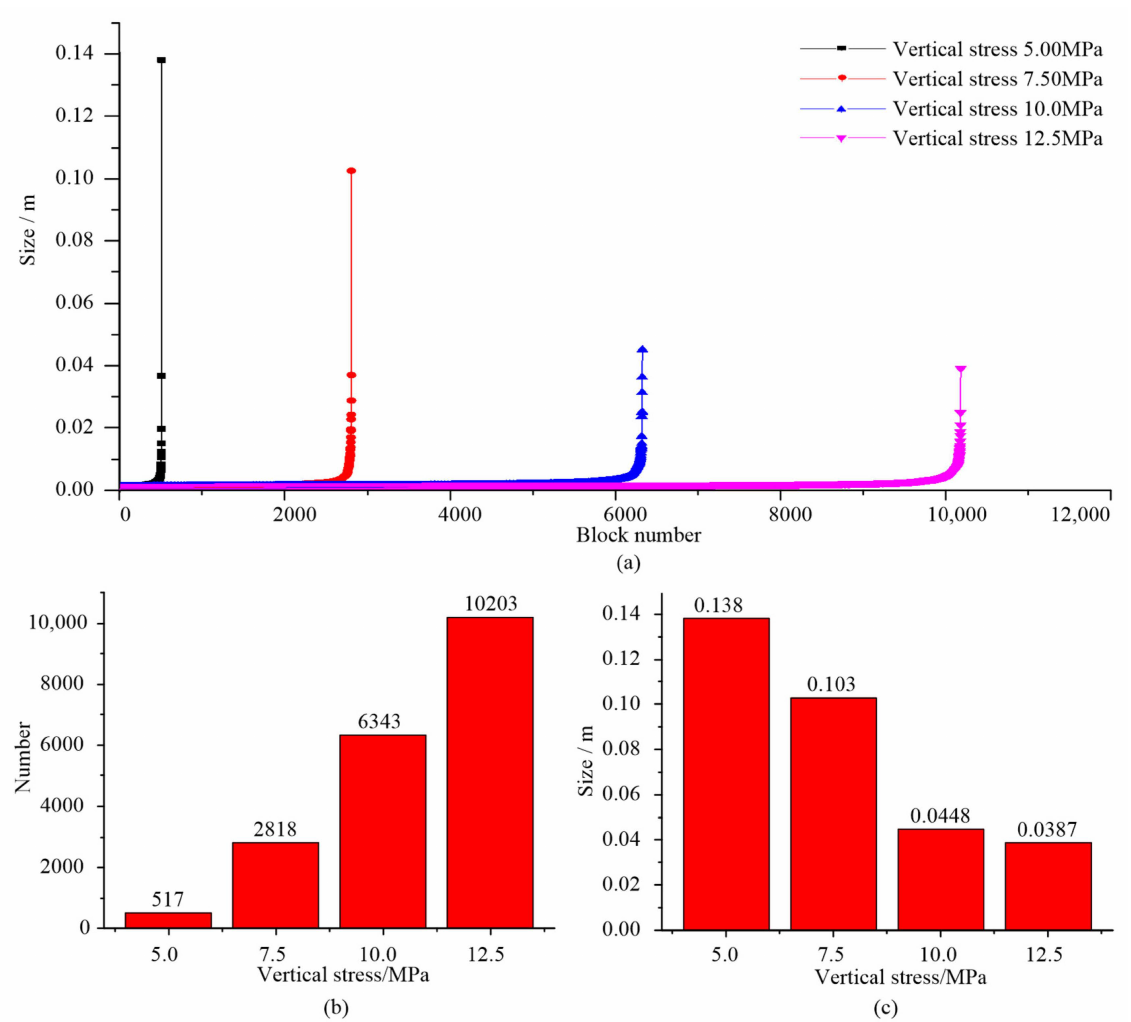
Figure 5. The maximum number and size statistics of the fracture block of coal samples under different in situ stresses: ( a ) characteristic size curves of fracture rock block; ( b ) fracture block number comparison; and ( c ) maximum block size